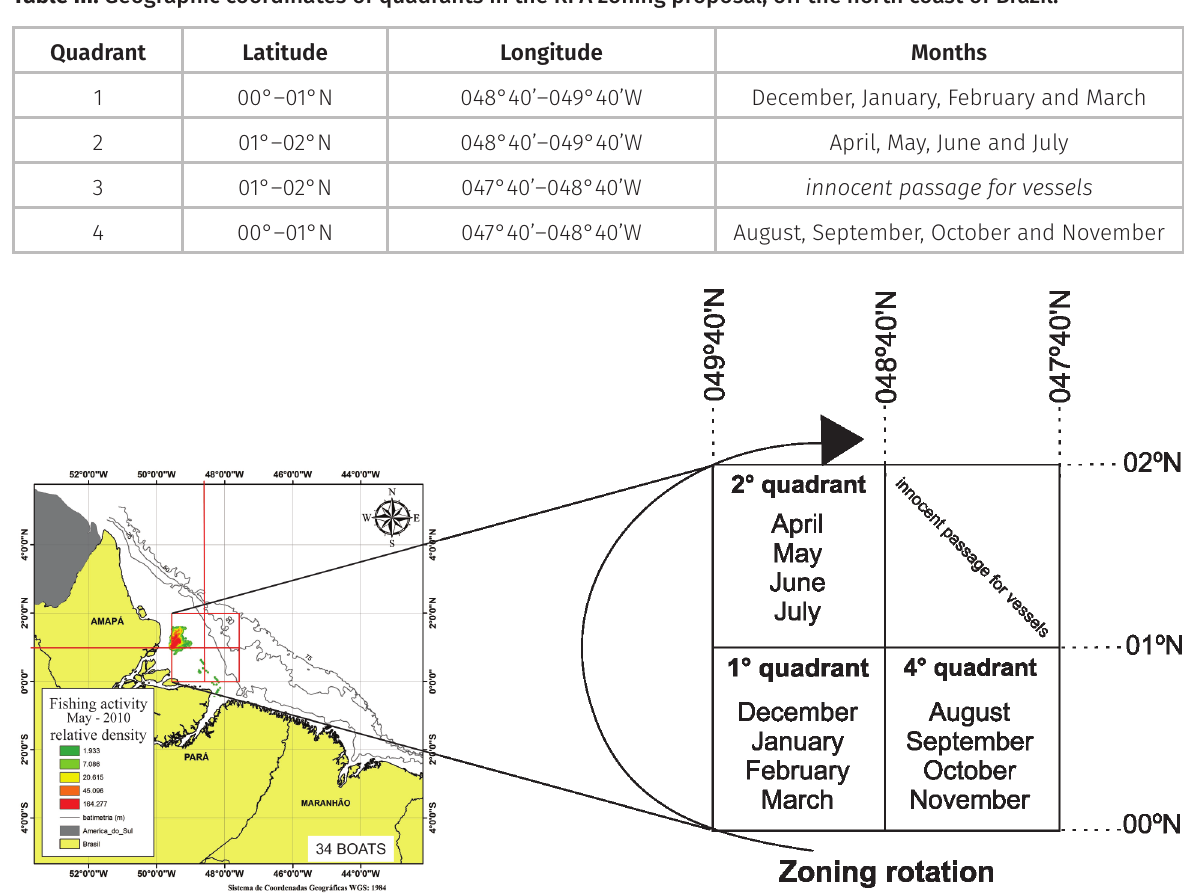
Figure 11. Schematic drawing of the proposed for the zoning of the industrial B. vaillantii fisheries of the North Coast of